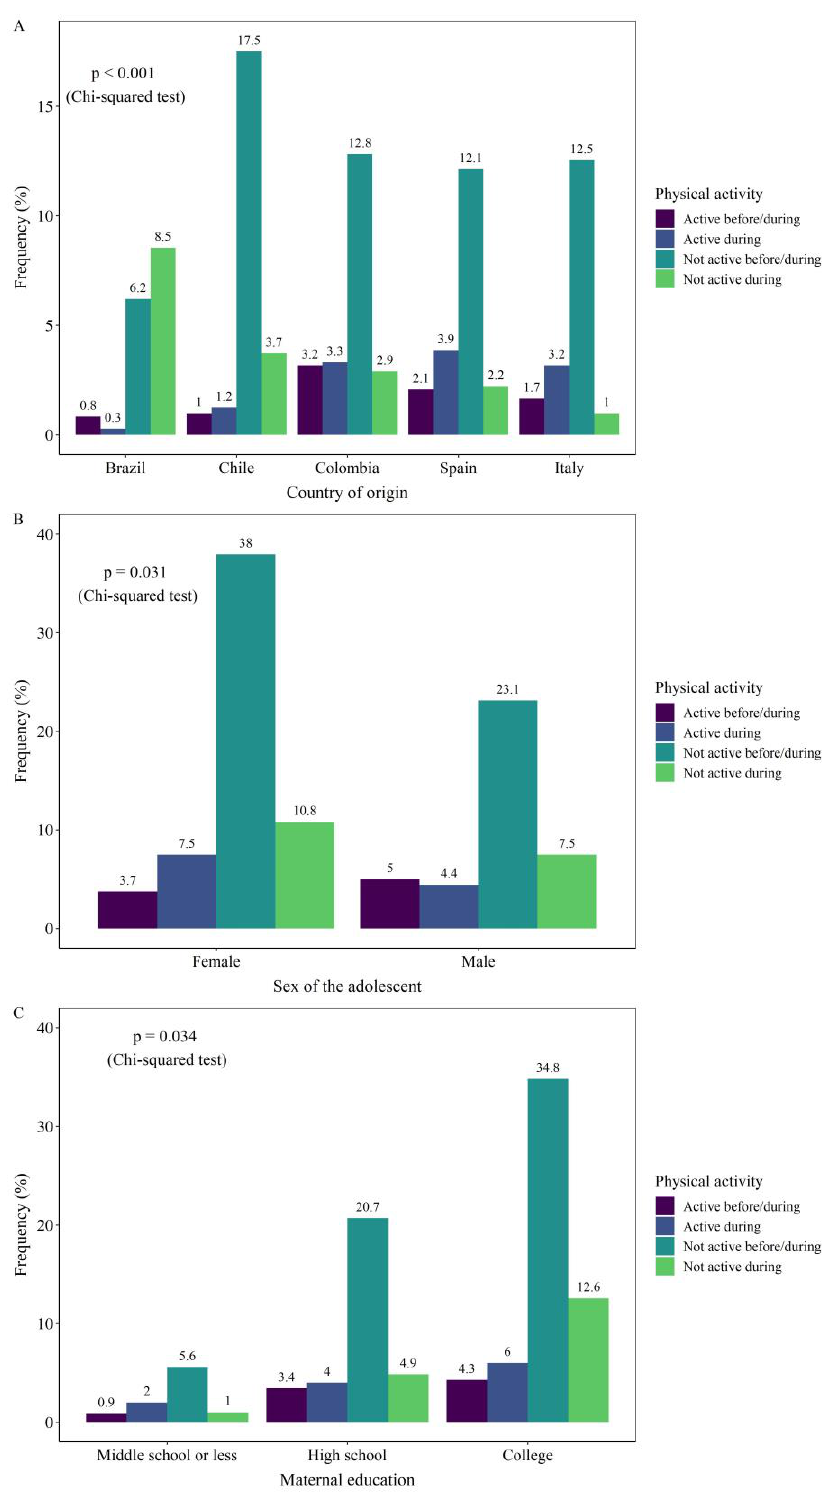
Figure 1. Prevalence of physical activity status before and during social isolation according to ( A ) country; ( B ) Sex of the adolescent; and ( C ) Maternal education. The final multivariate model was adjusted by continent, sex, number of people living in the same house, and maternal education (Table 3). It is shown that, after adjustment, only maternal education, sex, and continent seemed to play a role in the odds of physical activity / inactivity during the evaluated period. Adolescents living in Latin America presented an odds ratio (OR) of 2.98 (CI 95%